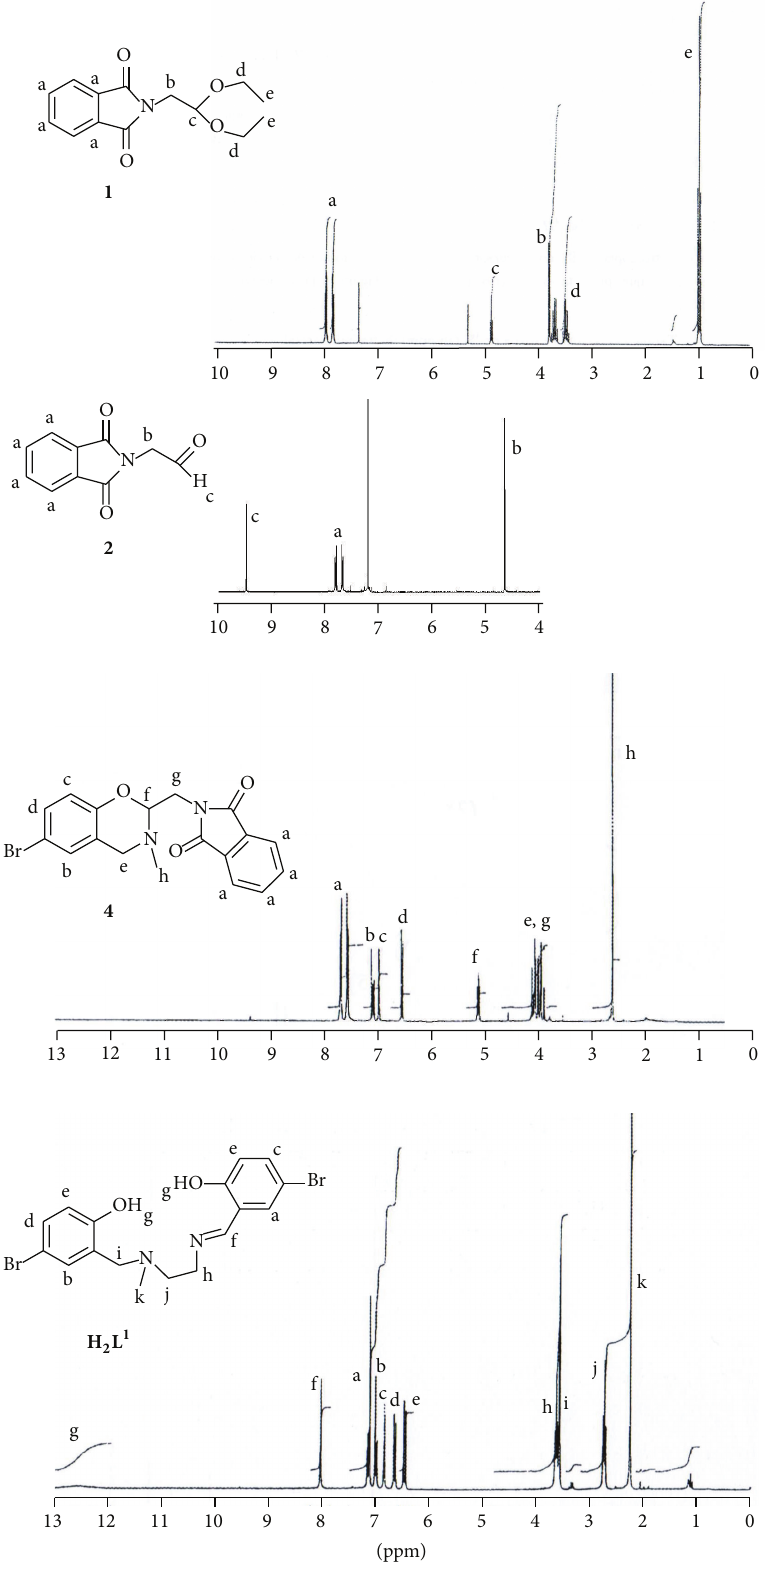
Figure 2: 1 H NMR spectra and assignments for 1 , 2 , 3 , and the ligand H 2 L 1